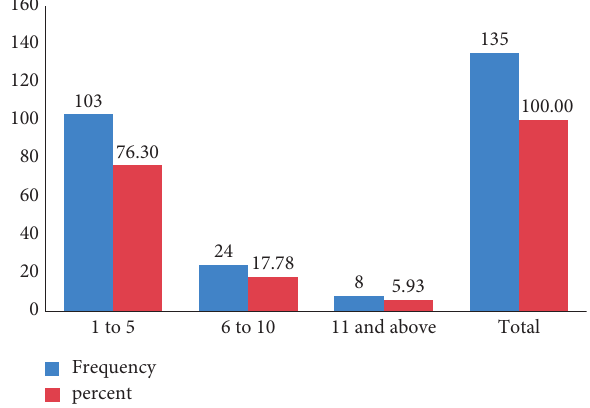
Figure 3: Frequency and percentage of bee colony ownership in the study